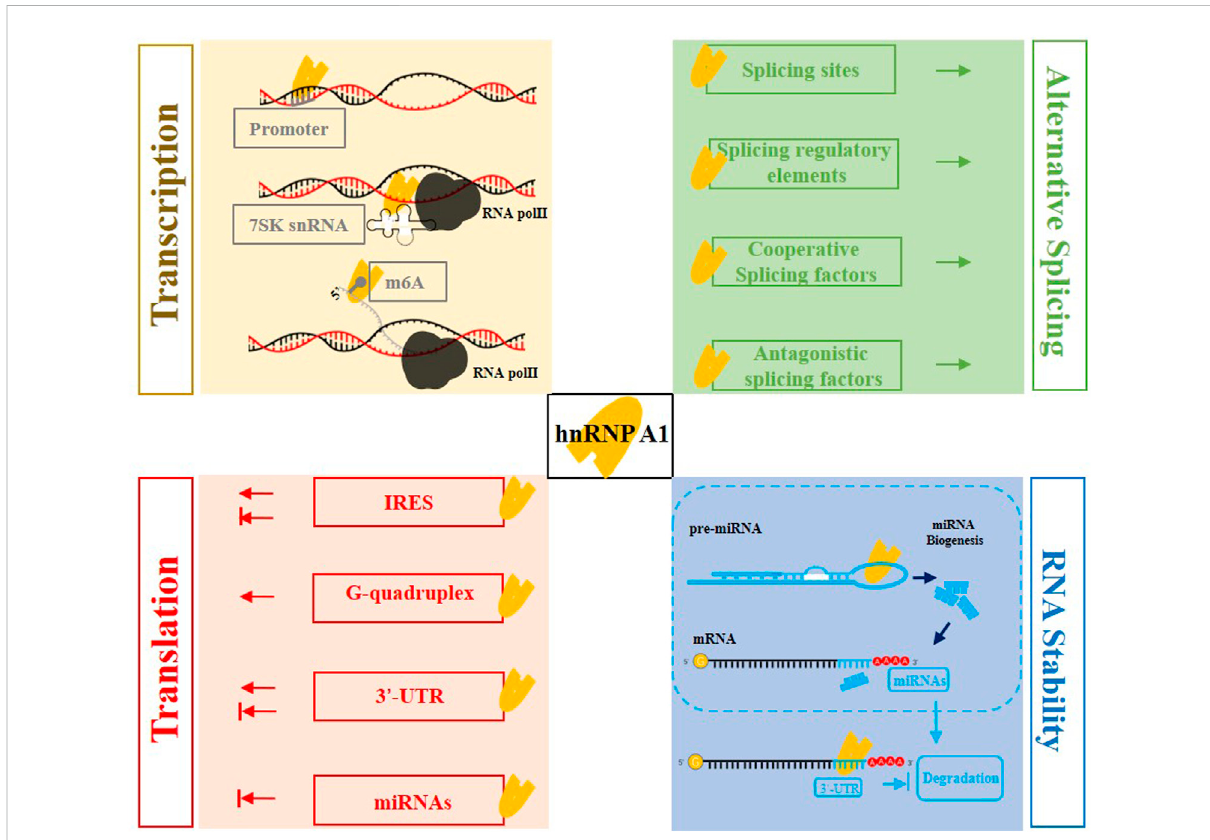
FIGURE 3 ThemultifacetedrolesofhnRNPA1inmRNAmetabolism.hnRNPA1affectsgenetranscriptionthroughbindingto7SKsnRNAordirectlybinding to the gene promoter; hnRNP A1 can be recruited to the m6A-modi fi cation, and act as a m6A “ reader ” to promote the transcription. hnRNP A1enhancesmRNAstabilitythroughbindingtospeci fi csitesof3 ′ -UTR.hnRNPA1alsocontributestothebiogenesisofmiRNAs,andthenthespeci fi c miRNAs suppress the mRNA translation or targeting the mRNA decreasing the stability. hnRNP A1 regulates alternative splicing events by binding to speci fi c splice sites and splicing regulatory elements, as well as interacting with cooperative or antagonistic splicing factors. hnRNP A1 increases gene translation by binding to G-quadruplex, and shows positive or negative effects when using its ITAF activity binding to IRES sequence or binding to 3 ′ -UTR of